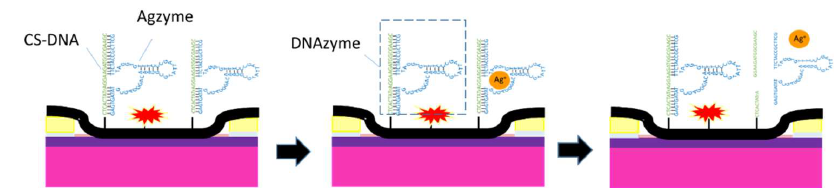
Figure 1. Schematic illustration of the detecting mechanism.